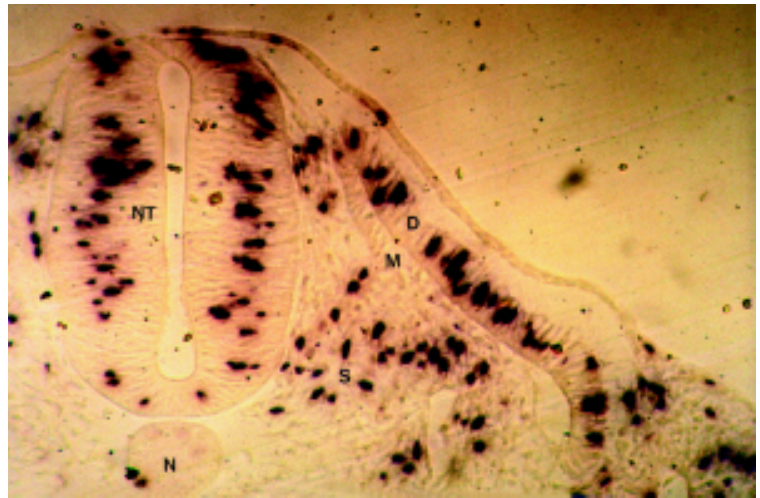
Figure 3 - Transverse section of a chicken embryo (56-h incubation) showing dark-stained BrdU-labeled nuclei of cells in the neural tube (NT), notochord (N), dermatome (D) and scleratome (S). Note the lack of staining in the myotome